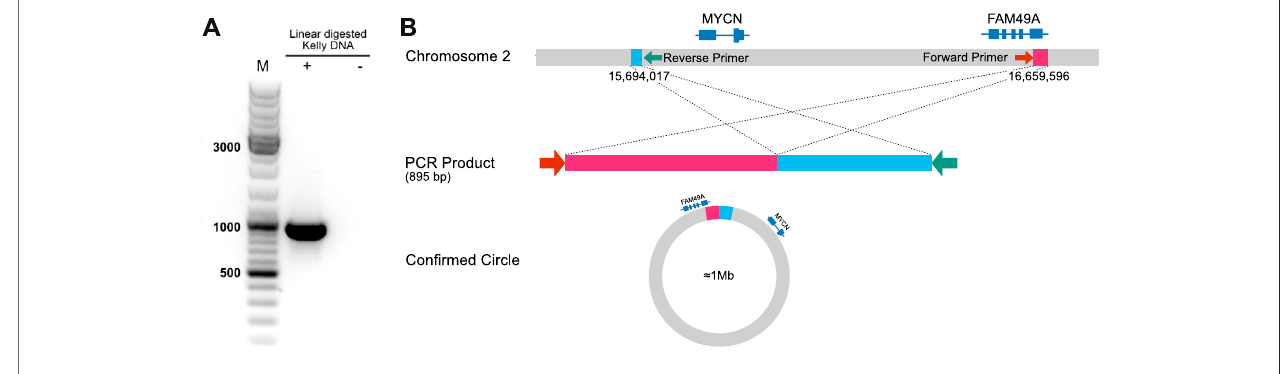
FIGURE 7 | Detection of an extracellular amplicon encompassing the MYCN oncogene in the cell line Kelly (A) Gel electrophoresis of ecDNA fragment, which was ampli fi ed by primers fl anking the breakpoint (B) Schematic representation and interpretation of Sanger sequencing